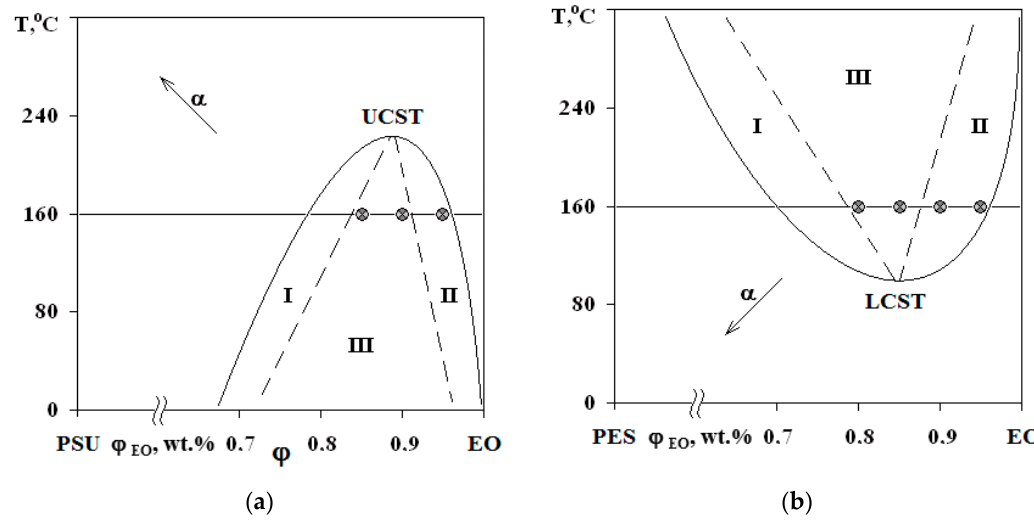
Figure 3. Interferograms of interdiffusion zones of the PSU–adduct system ( α = 0.22, T = 220 °C). P is the phase boundary, I is the diffusion zone of the adduct into the thermoplastic rigid-chain polymer (TP) and II is the diffusion zone of the TP into the adduct.